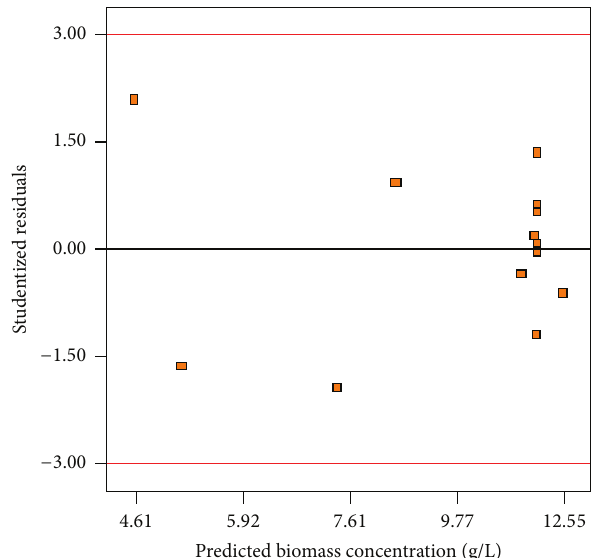
Figure 4: Plot of studentized residuals versus the predicted biomass